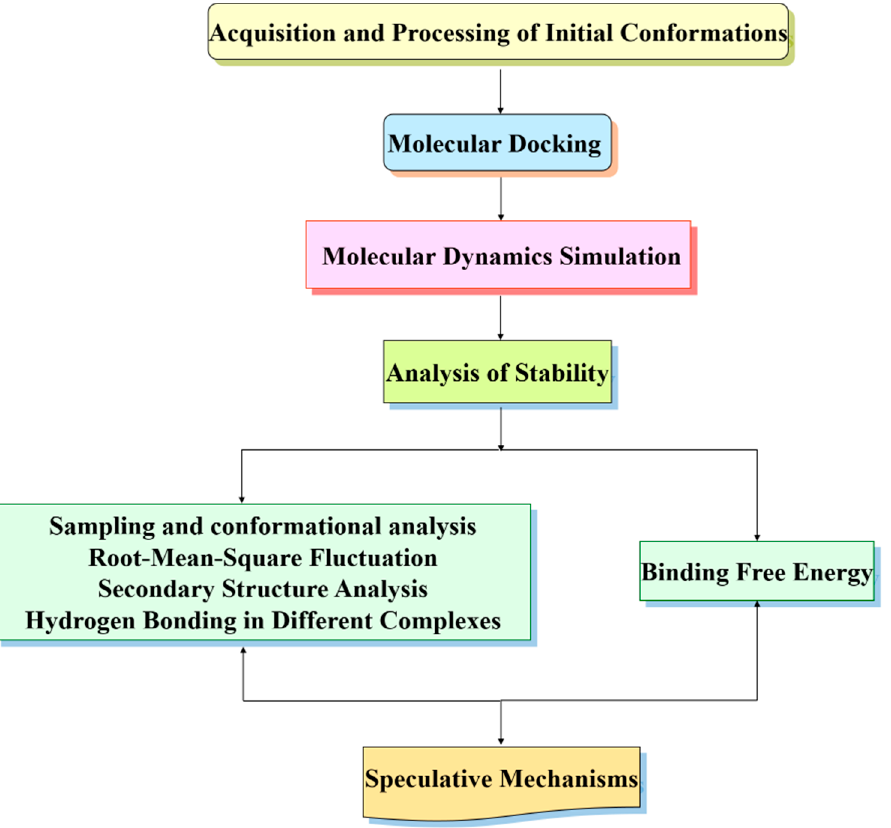
Figure 3. Workflow diagram of the computational study.